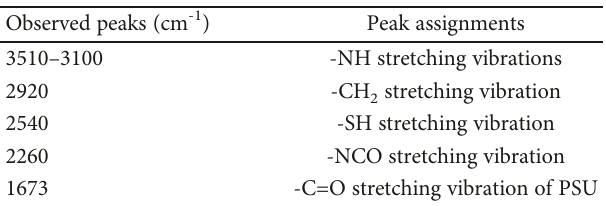
and cured PSU. o Table 1: Principal peak assignments in the FTIR spectra of BES, , and cured XDI, PSU o